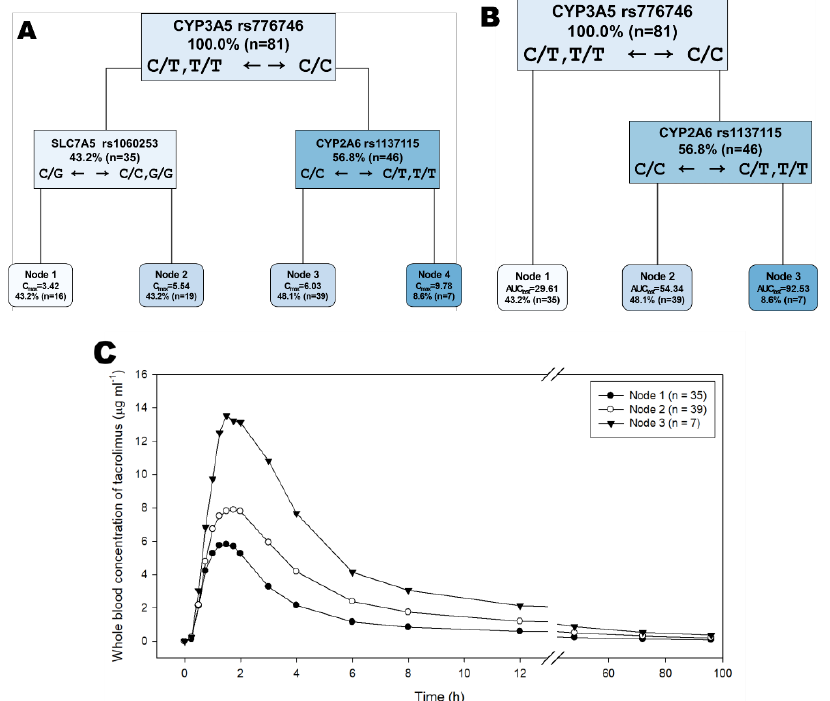
Figure 1. Simplified (depth: 3) decision tree for the maximum plasma concentration (C max , μg mL −1 , A ) and the area under the concentration curve from time zero to the last quantifiable time point (AUC last , h μg mL −1 , B ) of tacrolimus. The rectangles denote the branches, which contain the gene name, the single nucleotide polymorphism (SNP) accession number, proportion (%), and frequency of subjects, and the classifying alleles. The rounded rectangles represent the final nodes, in which the mean values of C max and AUC last , the percentage, and number of subjects are shown. ( C ) Mean concentration time profiles of tacrolimus by node for AUC last as identified in ( B ). Subjects in node 3 had the highest values of C max and AUC last . Table 1. Genetic variants associated with tacrolimus C max and AUC last identified by decision tree.